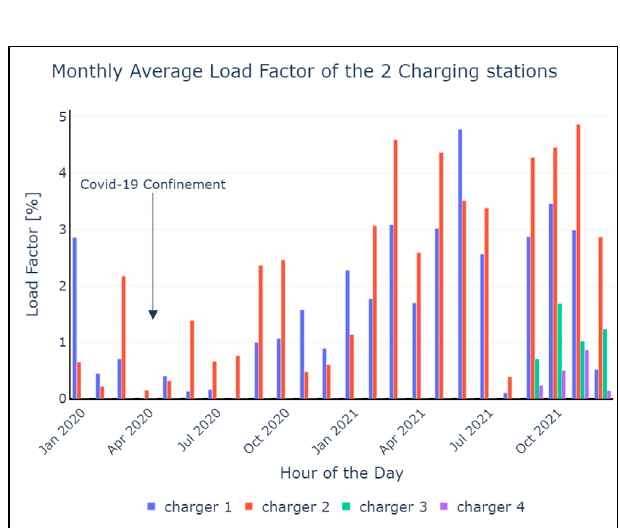
FIGURE 8 | Monthly mean load factor of the EV